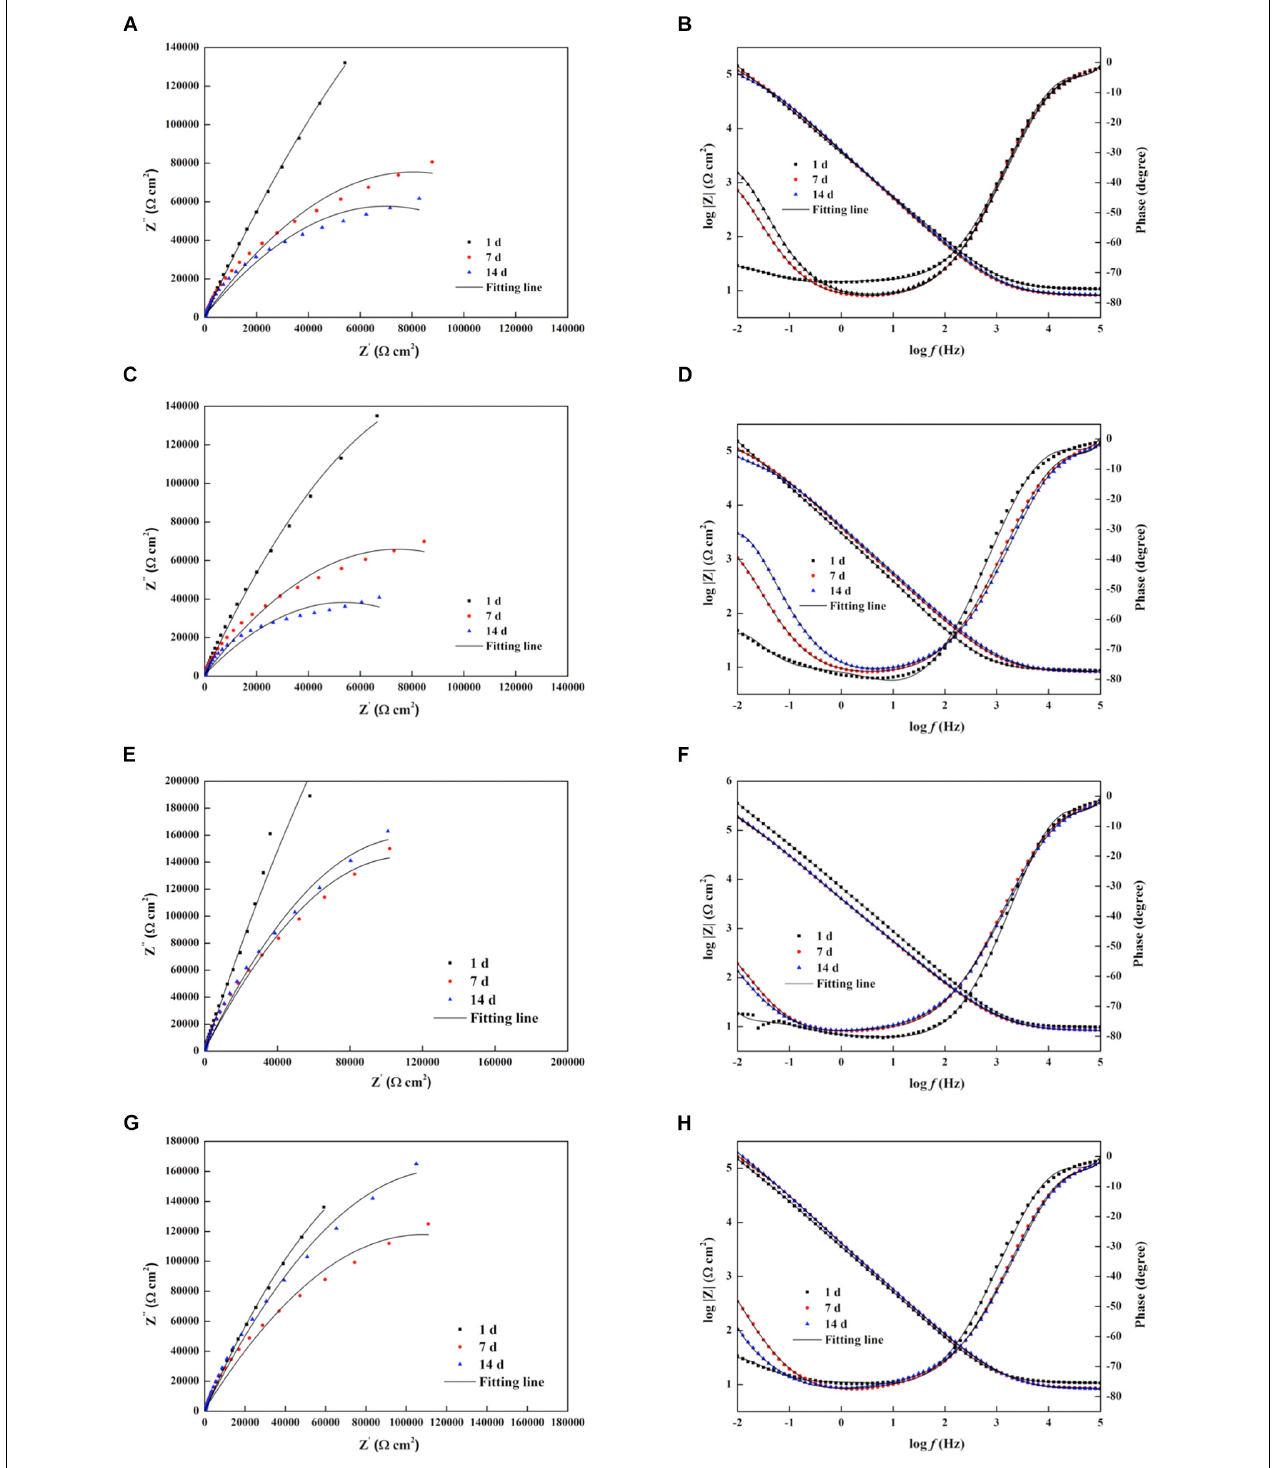
FIGURE 7 | Nyquist and Bode diagrams of the impedance measurements of different electrodes in the Pseudomonas aeruginosa -inoculated culture medium as a function of time. (A,B) 304L BM, (C,D) 304L WZ, (E,F) 304L-Cu BM, and (G,H) 304L-Cu WZ. The black solid lines are fitting impedance curves with proper equivalent circuits in Figure 8 . BM, base metal; WZ, welding